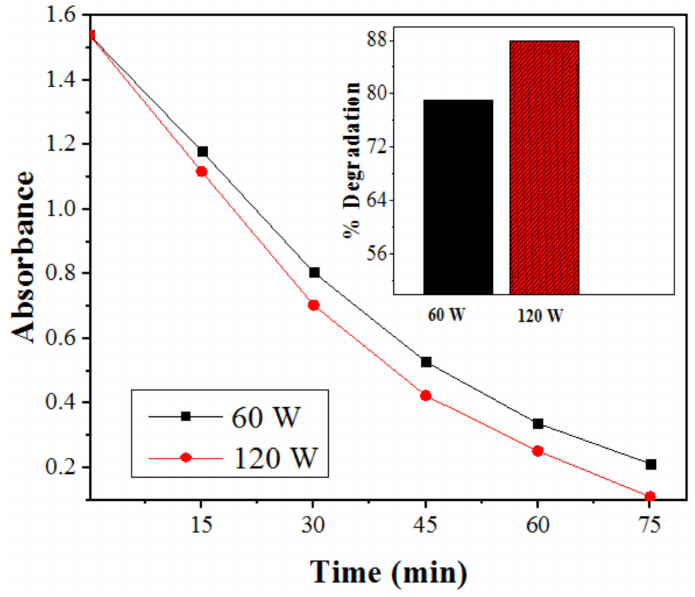
Figure 16. Effect of power on degradation of SDB at optimum conditions (15 mL of SDB, pH 6, 75 min irradiation, 40 mg